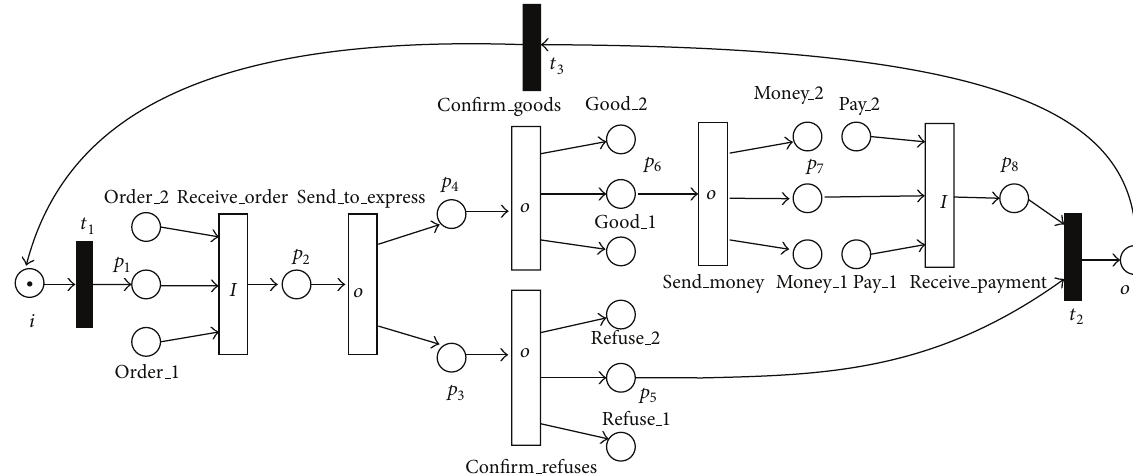
Figure 2: An online shop is modeled by the LPWN 𝑁 1